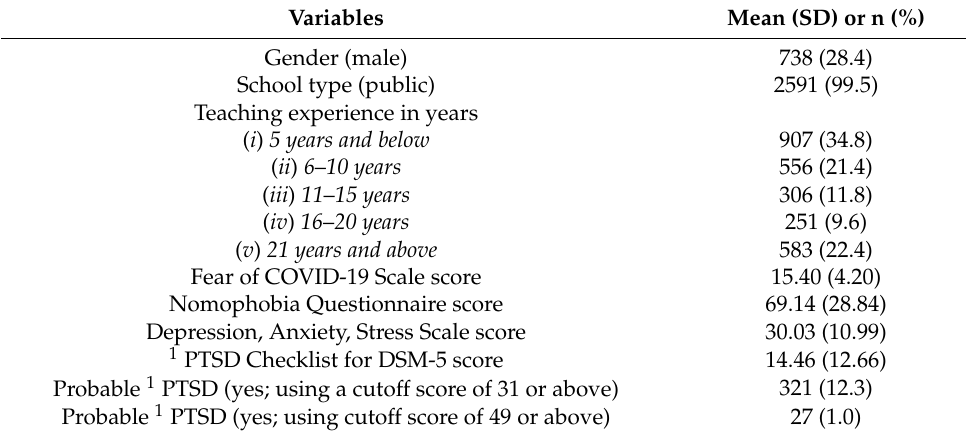
Table 1. Participant characteristics (N = 2603).